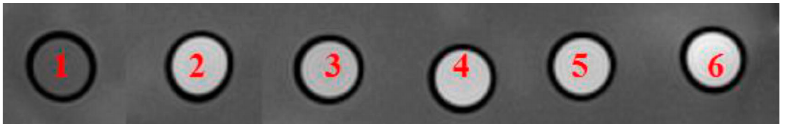
Figure 8. T1-weighted MRI of phantoms were made at 1.5 T, room temperature in correspondent buffer (10 mM HEPES, pH 7.0) and 100 µM Gd 3+ concentration. 3D SPGR TR = 500, TE = 10, a = 40°. (1)–H 2 O; (2)–Gd(NO 3 ) 3 ; (3)–Magnevist ® ; (4)-E2-13W4-Gd 4 complex; (5)–E1-W8-Gd 8 complex; (6)-E1-W12-Gd 12 complex.